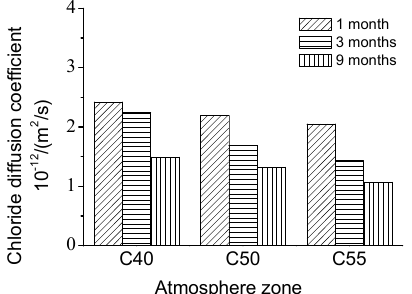
Figure 9. Chloride diffusion coefficient of C40, C50, and C55 exposed to the atmosphere zone after different times.